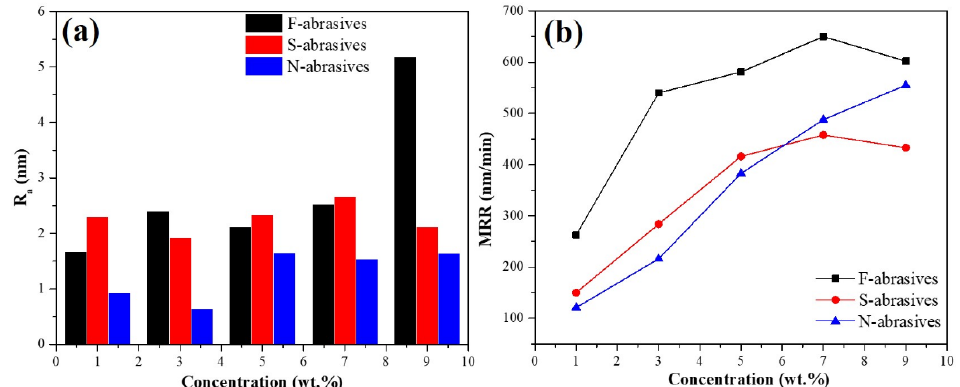
Figure 7. The R a ( a ) and the MRR ( b ) of TFT-LCD glass substrates polished by the ceria-based abrasives slurry with different concentrations.